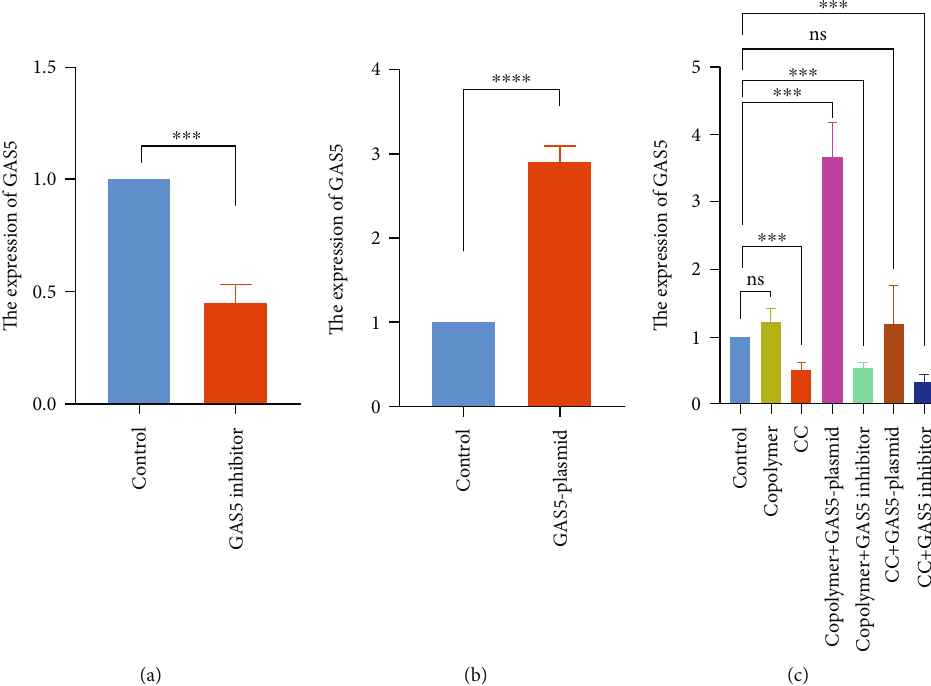
Figure 1: Triblock copolymer-encapsulated curcumin nanomicelles downregulate lncRNA GAS5 expression. (a, b) Transfection e ffi ciency detection. (c) Detection of the expression of lncRNA GAS5 through RT-PCR ( ∗ P < 0 : 05 , ∗∗ P < 0 : 01 , ∗∗∗ P < 0 : 001 , and ∗∗∗∗ P < 0 : 0001 ; ns: not signi fi